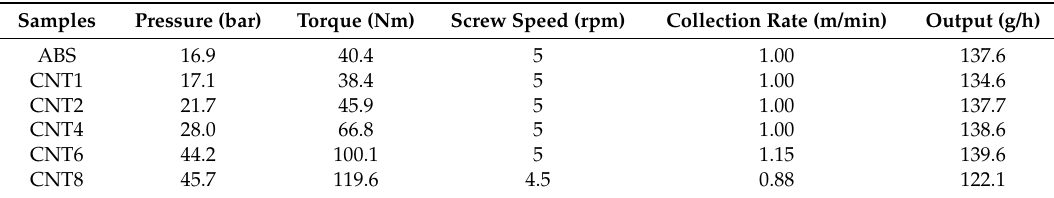
Table 1. Processing parameters of twin screw extruder for the production of ABS and ABS/CNT nanocomposite filaments.